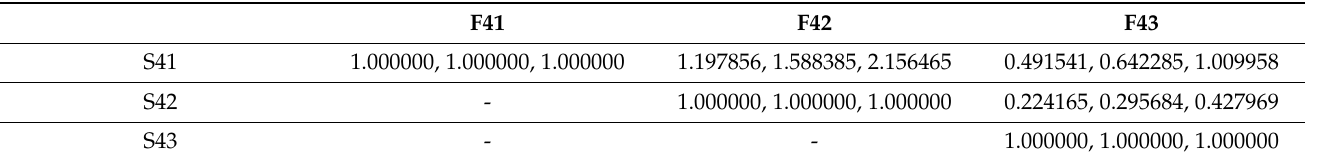
Table 5. The fuzzy-aggregated pairwise comparison matrix at Level 2 for design.